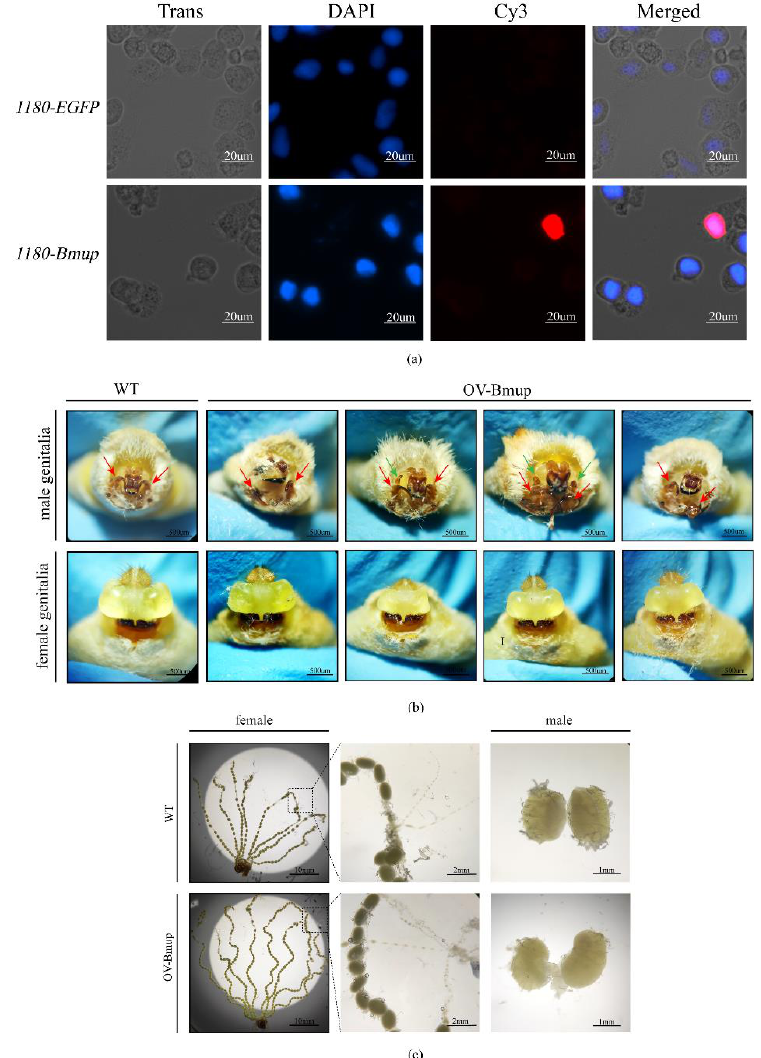
Figure 4. Cellular location of the BmUP gene and observation of the phenotype of overexpressing silkworms. ( a ) Subcellular location of BmUP in the silkworm cell lines (BmN) and pSL1180-EGFP treated cells as a control. DAPI-treated nuclei, red fluorescence for Cy3-treated UP protein and merged images are shown. ( b ) Observation of external genitalia in Over-BmUP transgenic strains. WT represents wild-type, and OV-BmUP represents overexpressing individuals. The red arrow represents the clasper, and the green arrow represents hyperplastic tissue. ( c ) Observation of the gonads. The female fallopian tube and the male testis is shown.